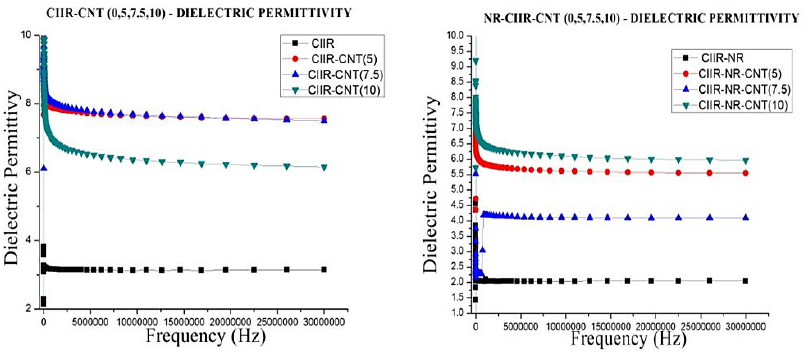
Figure 13. Frequency dependencies of dielectric permittivity of CIIR and NR/CIIR blend rubber nanocomposites with different filler concentrations.